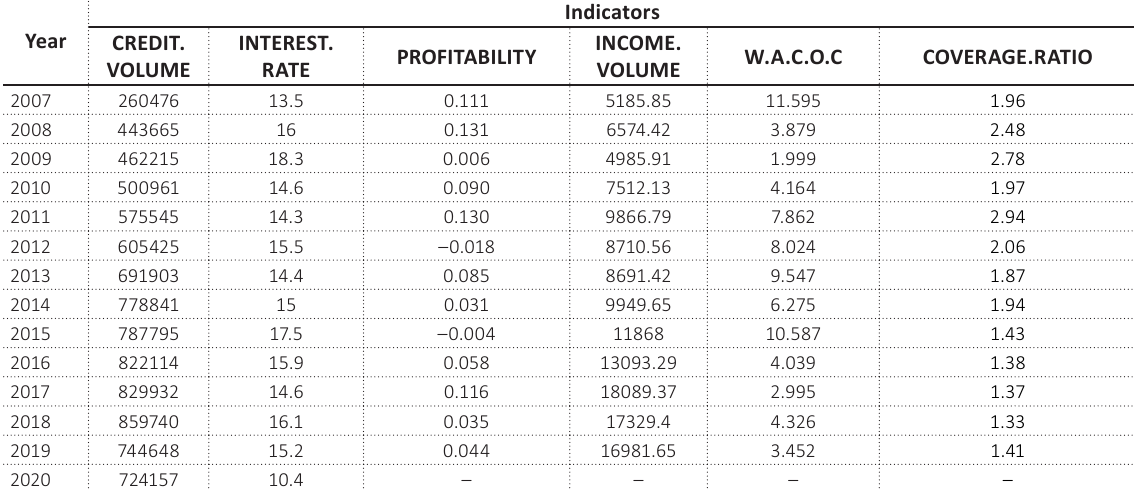
Table 2. Statistical data for structural equation